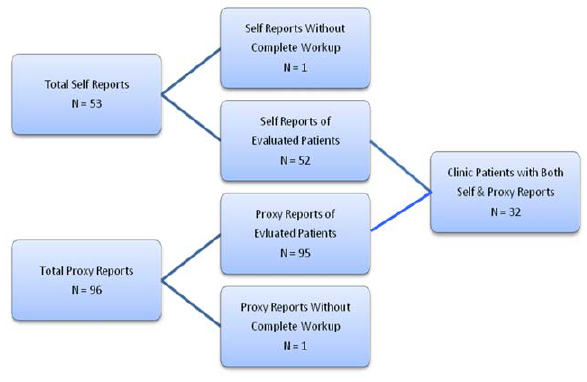
Figure 2. Clinical Validation Sample.